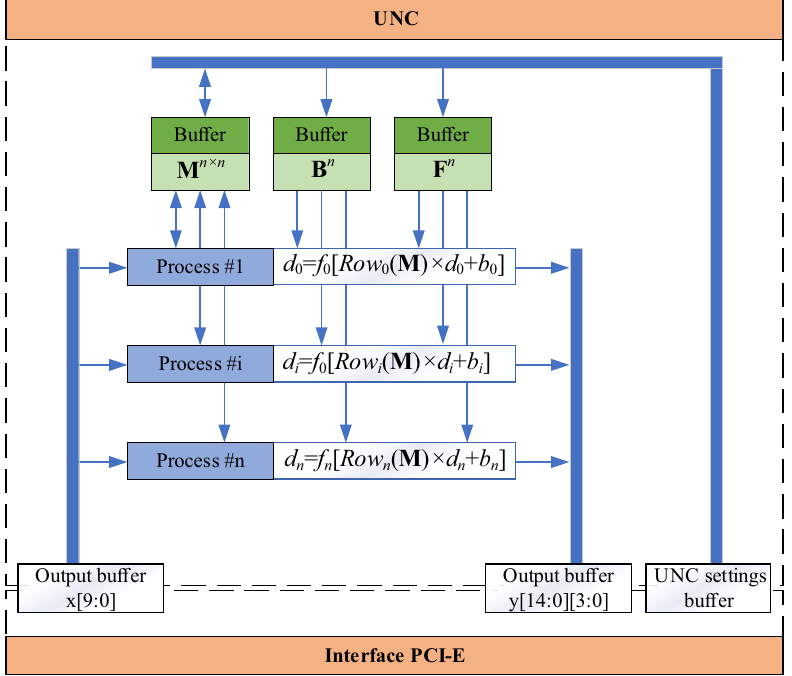
Figure 7. The structure of the HDL-project for FPGA implementing the